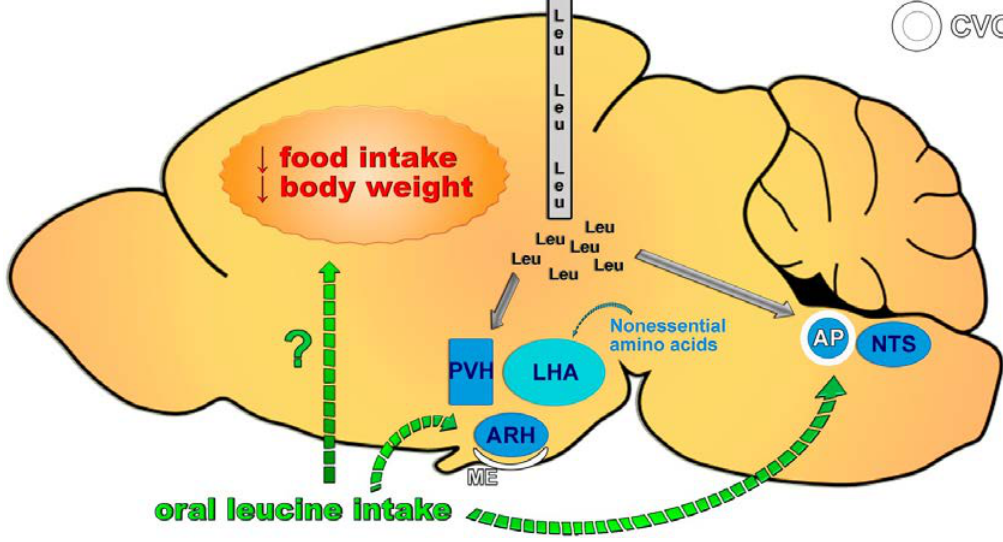
Figure 3. Neuronal circuitries required for the central effects of leucine on feeding. Central leucine administration (intracerebroventricular or parenchymal) acutely decreases food intake and body weight. This response is due to the activation of hypothalamic nuclei involved in regulating energy balance, including the paraventricular nucleus of the hypothalamus (PVH) and the arcuate nucleus of the hypothalamus (ARH), as well as extra-hypothalamic sites such as the nucleus of the solitary tract (NTS). Conversely, oral leucine administration does not induce neuronal activation in the PVH, ARH, or NTS but does cause c-Fos expression in the area postrema (AP). Consequently, no robust evidence indicates that oral leucine intake affects food intake. CVO, circumventricular organ; ME, median